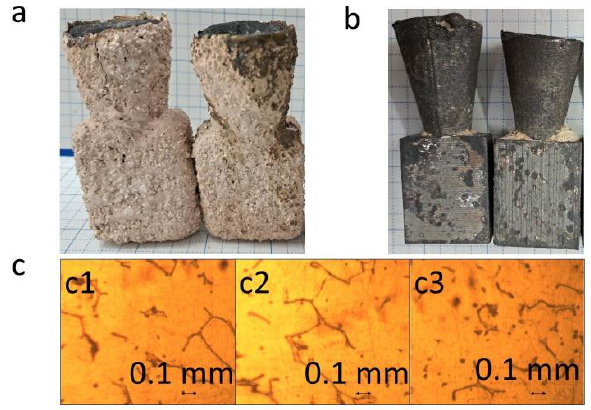
Figure 6. ( a ) Poured metal. ( b ) Casted part. ( c ) Microstructure of casting sample (( c1 – c3 ) obtained from the wax, PLA, and PVB patterns,